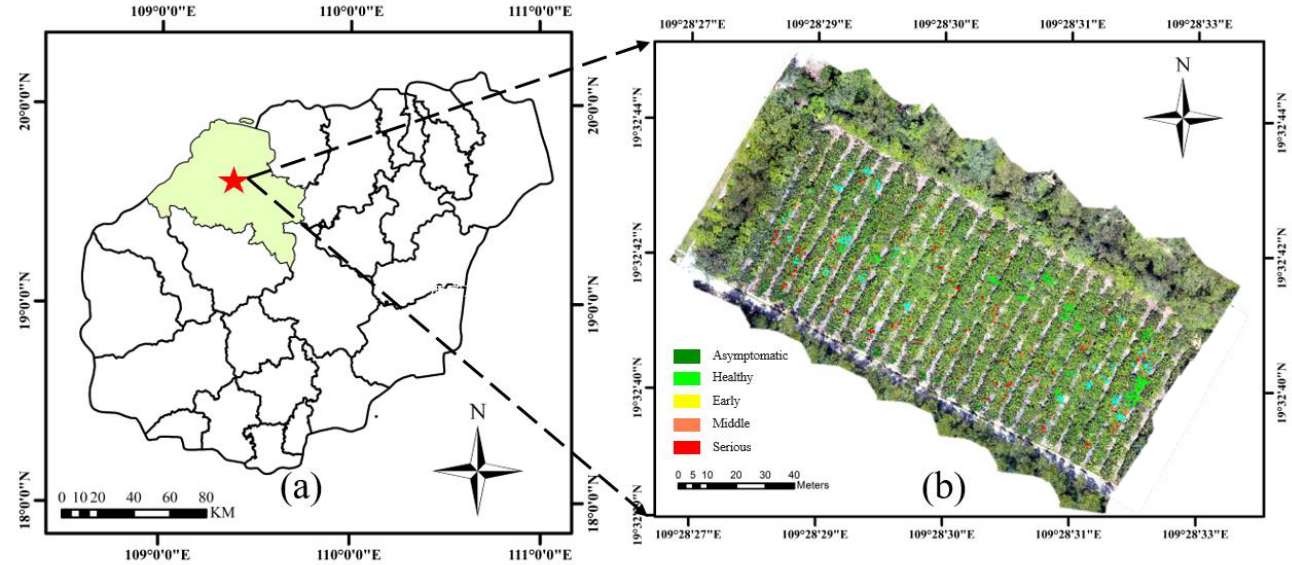
Figure 1. Location of the study area. ( a ) Rubber forest research area of China Academy of Tropical Agriculture, Danzhou City, Hainan Province, China; ( b ) UAV multispectral image.